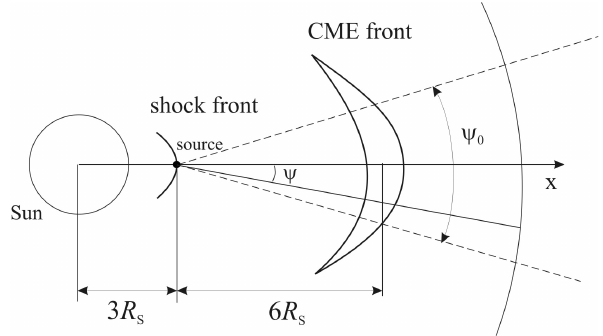
Fig. 4. Geometry adopted for the